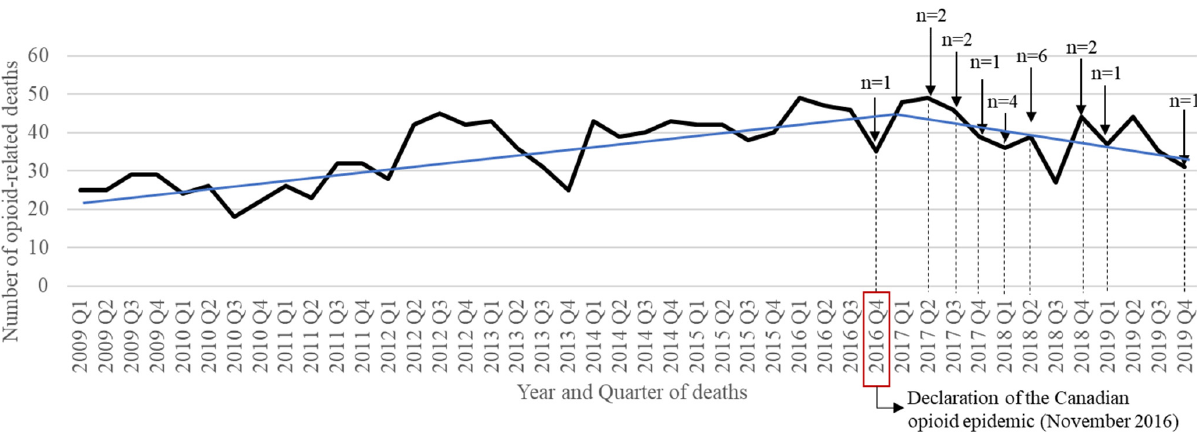
Figure 3. Number of opioid-related deaths in Quebec between 2009 and 2019. The arrows and corresponding dashed lines represent the number of interventions and policies implemented at that moment in time. The linear blue lines represent the trend in the number of opioid-related deaths in time before and after the declaration of the Canadian opioid epidemic.